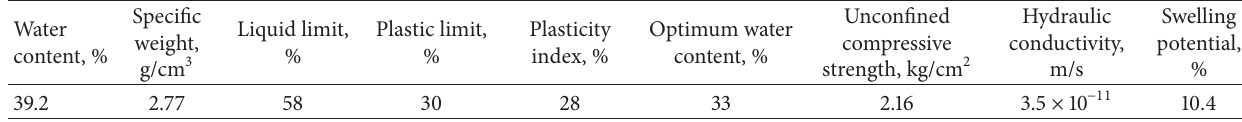
Table 1: Geotechnical properties of CW.